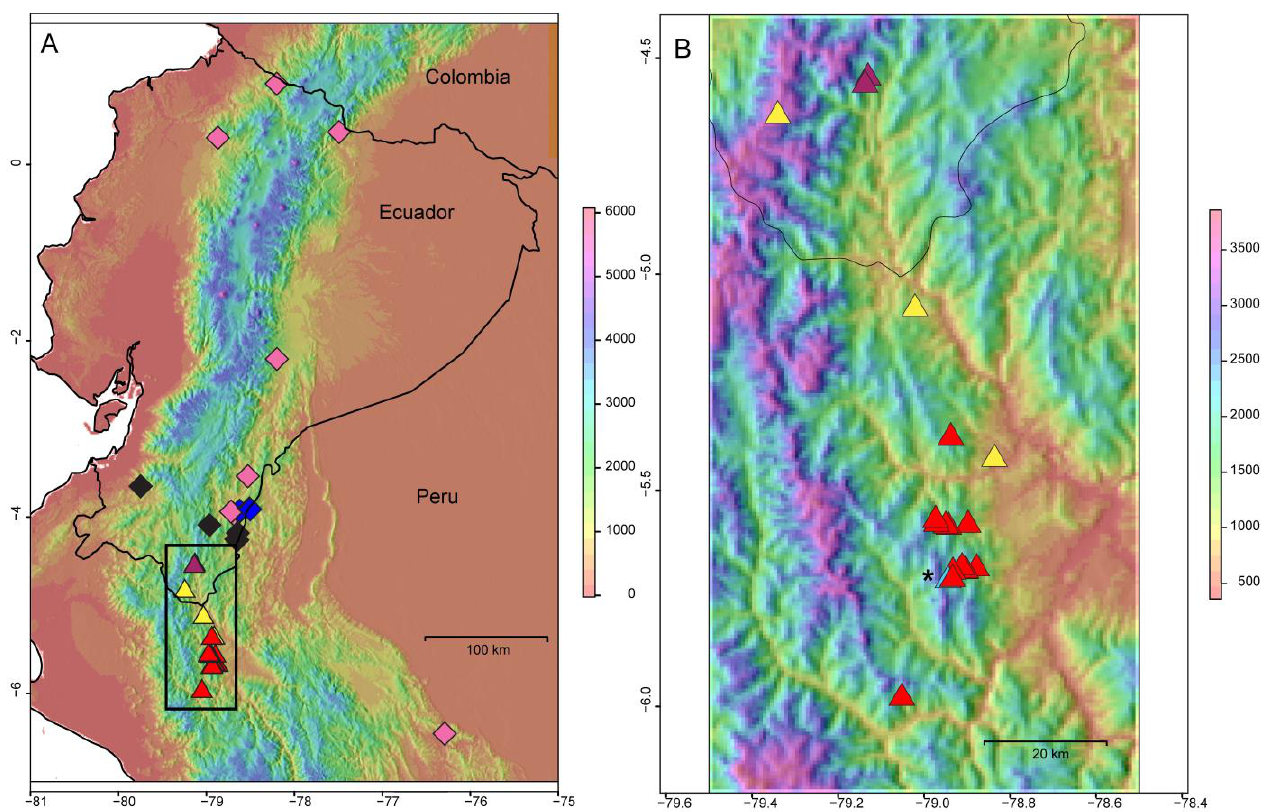
Figure 2. Map of the sampling sites of the populations analyzed in this study. ( A ) All populations sampled. Diamonds indicate the populations of the genetic cluster B inferred with the Bayesian clustering program STRUCTURE. The pink diamond corresponds to the populations of the sub- cluster B1 ( M. cortinae, M. illuminata, M. lenae, M. pringleana, M. quechua, M. sodiroana, M. sp. nov., M. umbellata ; see Table 1), the black to the sub-cluster B2 ( M. pacifica , lenae , quizhpei ) and the dark blue to the sub-cluster B3 ( M. dies-viridis ). Triangles indicate the populations of cluster A. The magenta triangles correspond to the sub-cluster A1 ( M. claireae ), the yellow to A2 and the red to A3 ( M. xerantifulva ). ( B ) Zoom on the Rio Chinchipe valley and the distribution of cluster A ( M. claireae and xerantifulva ), including the sub-cluster A4 (light blue and asterisk) not visible in ( A ). Table 1. List of populations included in this study. For each population, a voucher ID, country